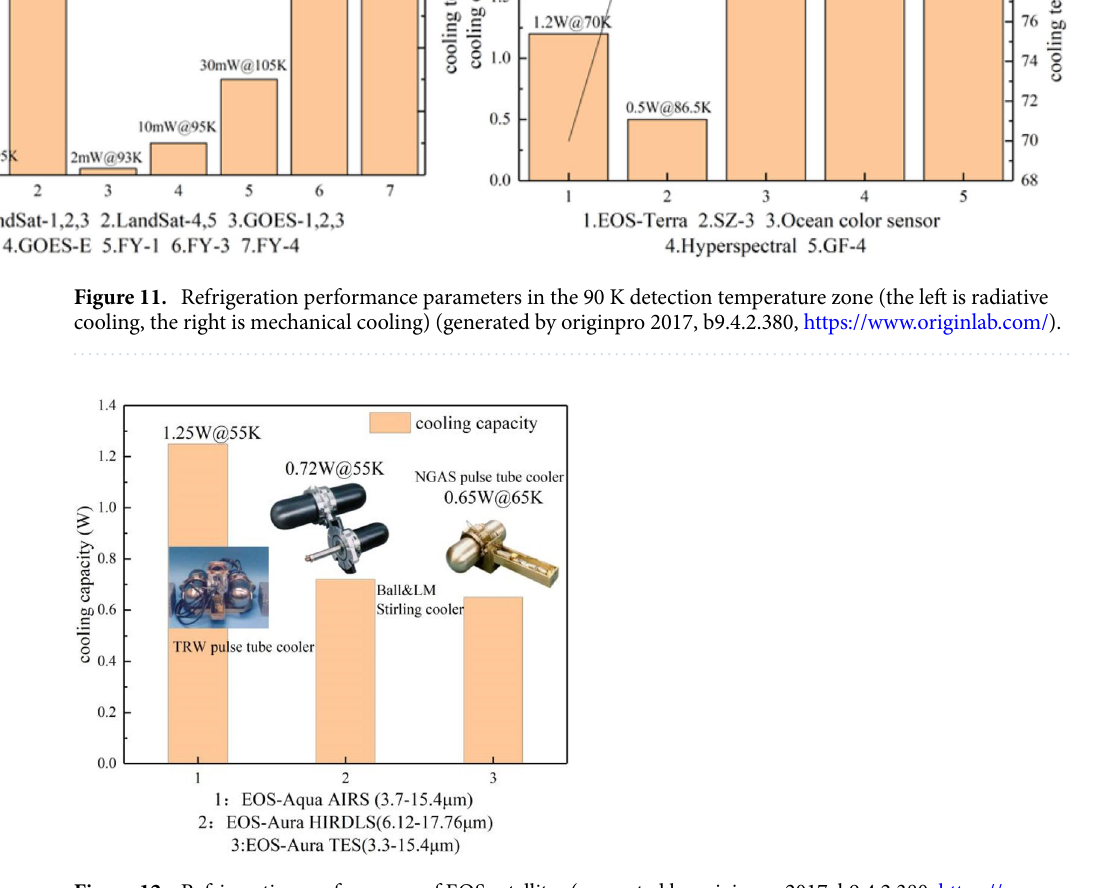
Figure 12. Refrigeration performance of EOS satellites (generated by originpro 2017, b9.4.2.380, https:// www. origi nlab. com/).